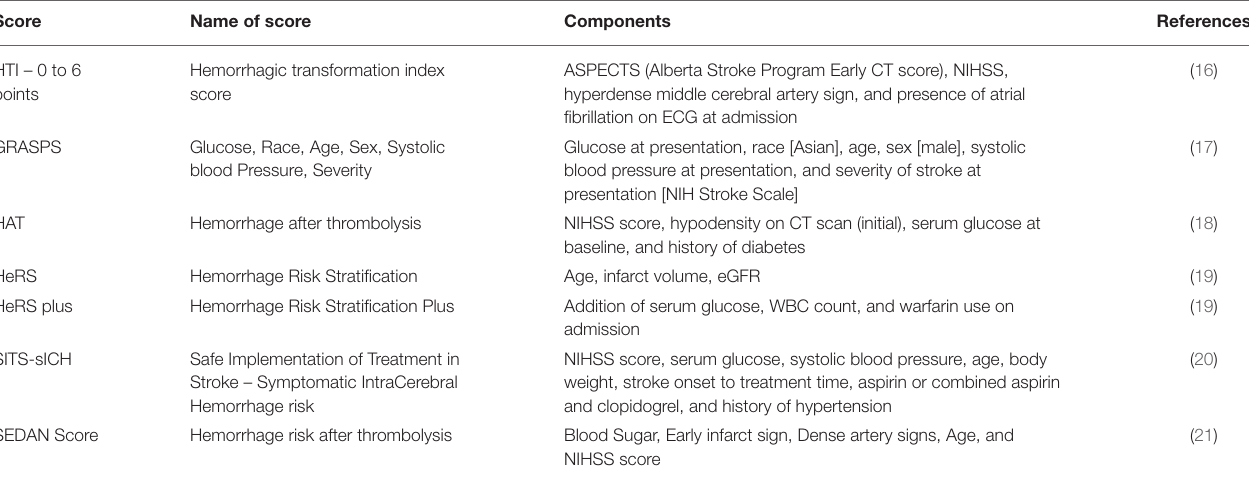
TABLE 4 | Risk scores proposed for HT prediction with alteplase